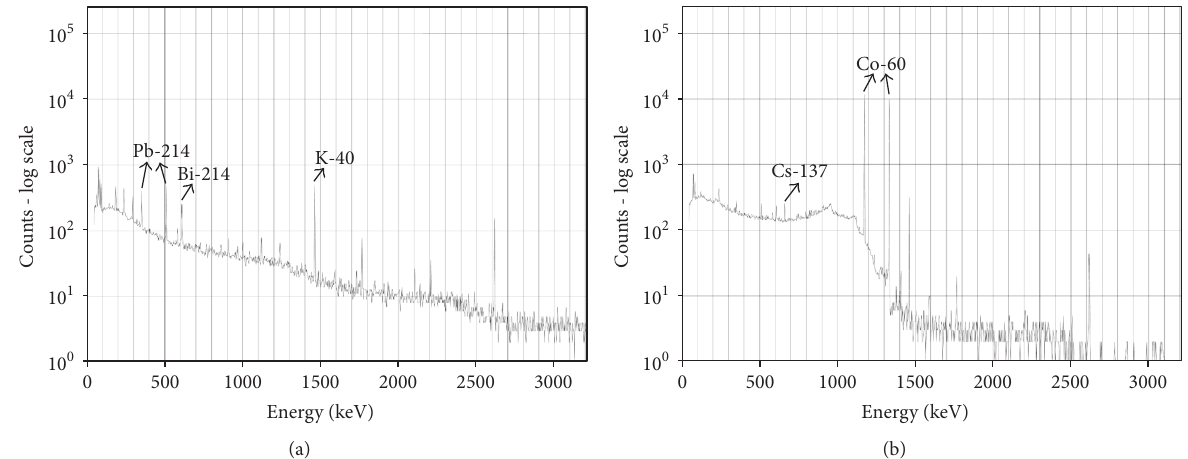
Figure 11: The qualitative 𝛾 spectrum measurement. (a) Background; (b) dust sample.